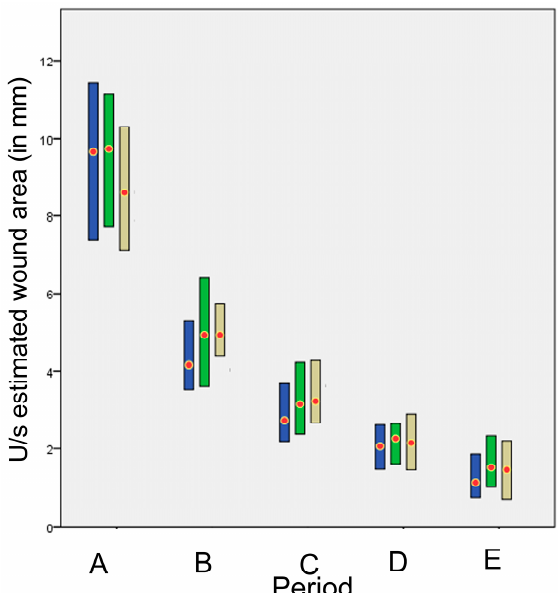
Figure 12. Ultrasonographic image of the wound area closed with glue, on the 9th po.d. The epithelial gap is evident between the epididymal edges at the wound area (arrow). The image is compressed laterally to facilitate viewing (scale is in mm).